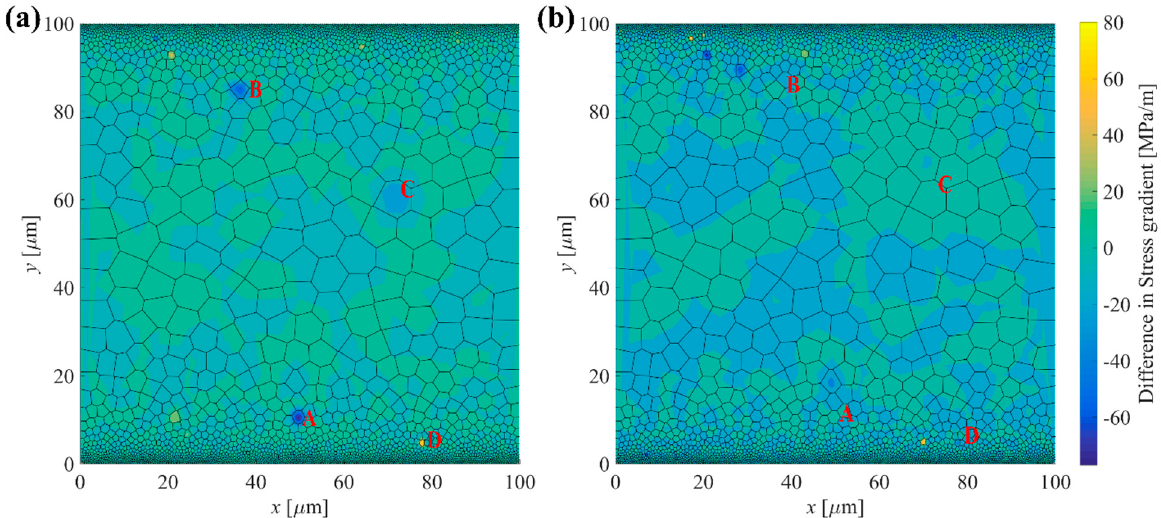
Figure 9. Difference in stress gradient at 5.0% and 5.1% strain for specimens with gradient structures (texture 2) under ( a ) tension and ( b ) compression. Points A to D (marked in red) are grains that endure significant stress gradient change and slip transmission.